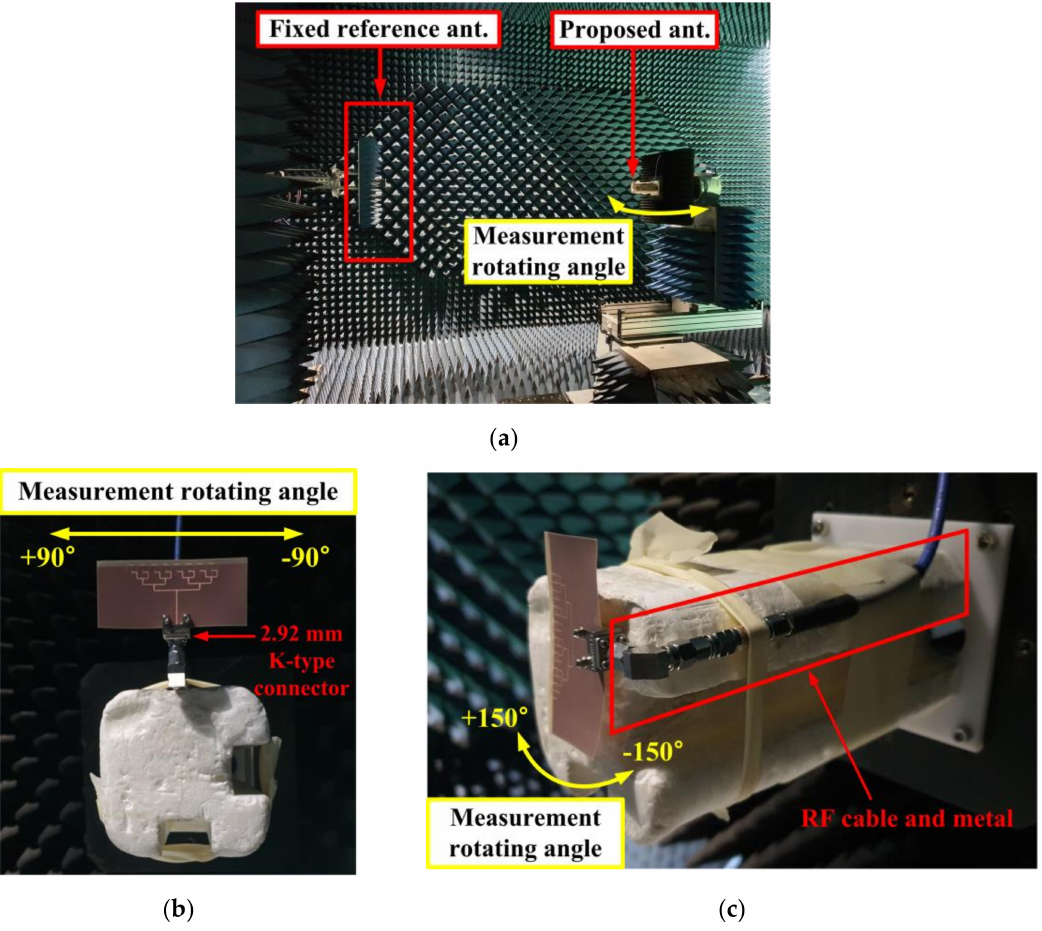
Figure 18. Measurement setup: ( a ) measurement setup in an anechoic chamber, ( b ) measurement setup for the yz plane radiation pattern, and ( c ) measurement setup for the xz plane radiation